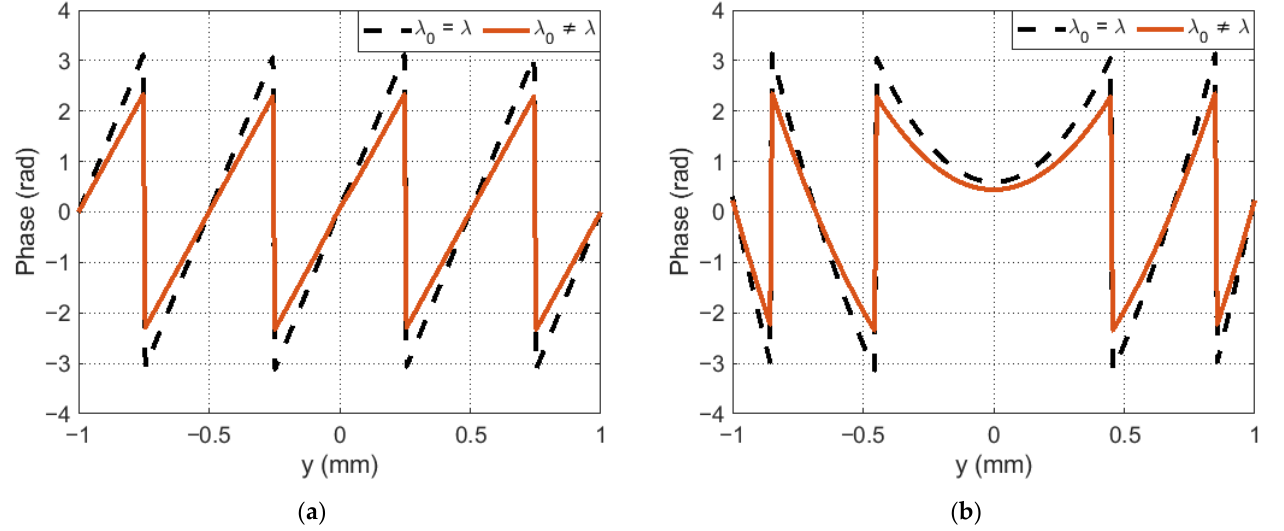
Figure 2. Phase function cross section: ( a ) object wave; ( b ) reference wave in the hologram recording plane.